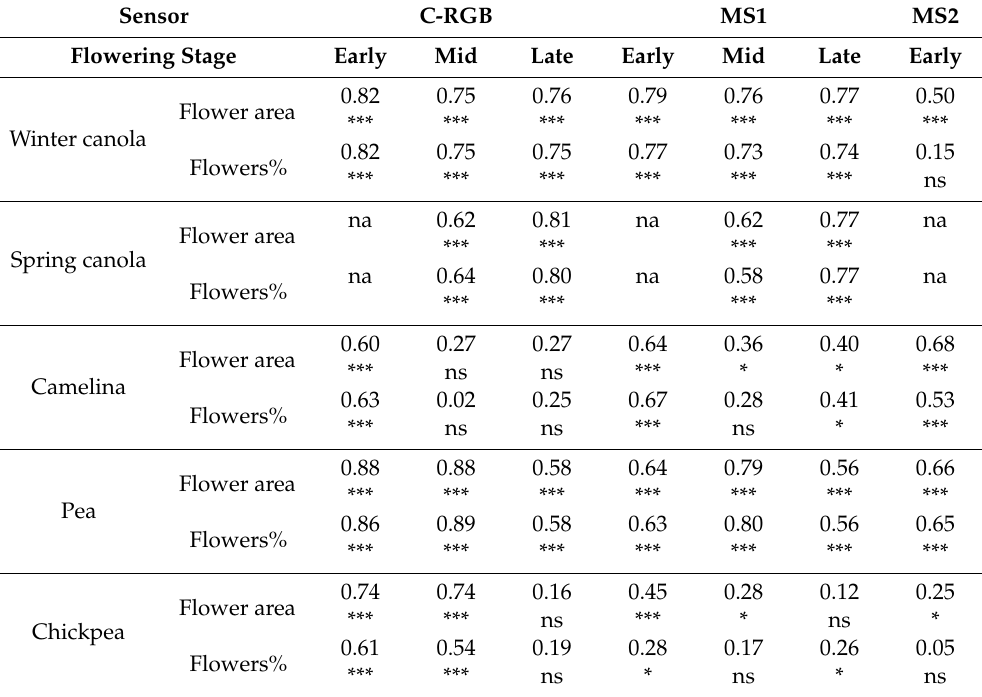
Table 3. Correlation coe ffi cient between features extracted from proximal sensing (1.6–2.2 m AGL) data and visual rating scores on